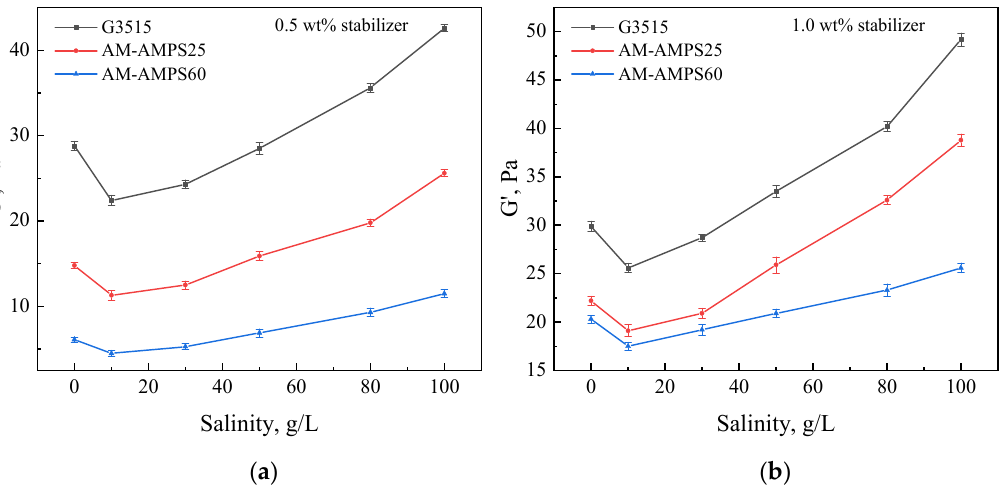
Figure 13. Strength changes of gels prepared with 0.5 wt% polymer and 0.5 wt% crosslinker and different concentrations of stabilizer after 30 days of aging in brines with different salinities: ( a ) 0.5 wt% stabilizer; ( b ) 1.0 wt% stabilizer.